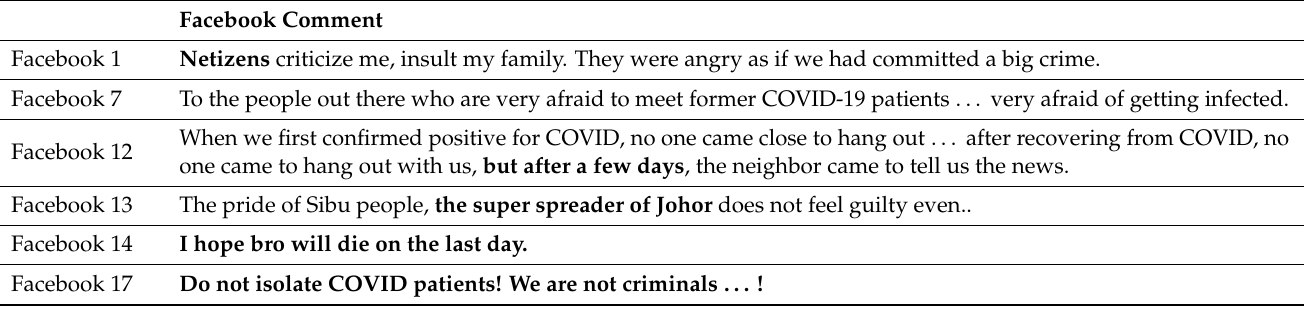
Table 1. Examples of stigmatization of COVID-19 patients in Facebook comments on health (N =